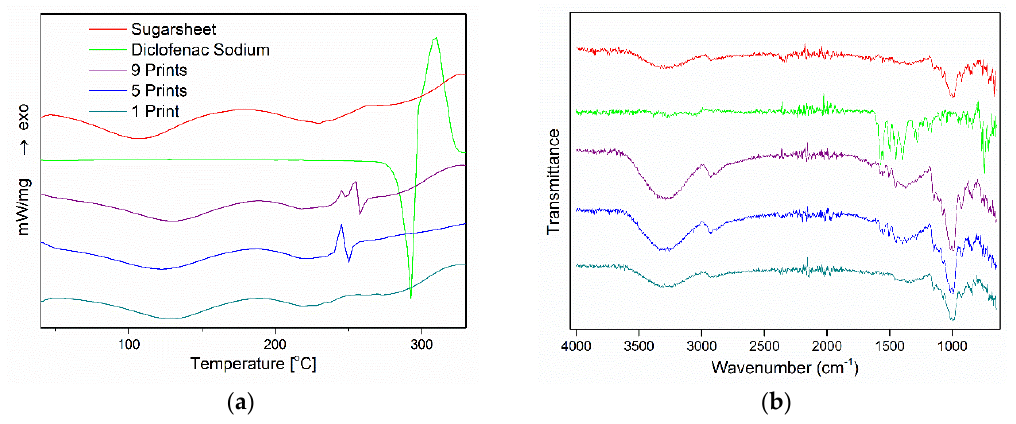
Figure 3. ( A ) DSC thermograms and ( B ) FTIR spectra of pure components and drug ‐ loaded formulations.